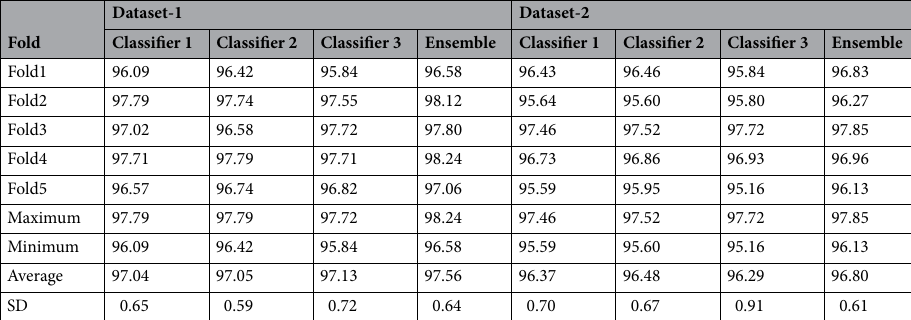
Table 6. Accuracies (in %) while evaluating using 5-fold cross validation scheme.